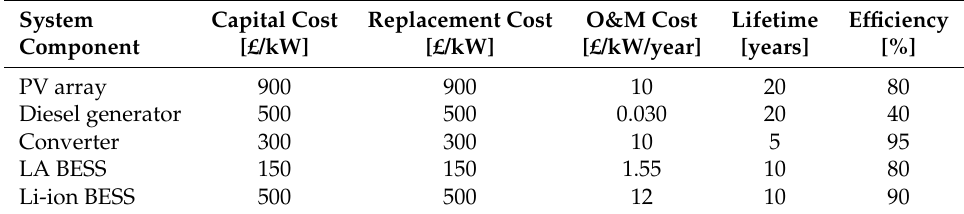
Table 2. Input data regarding system